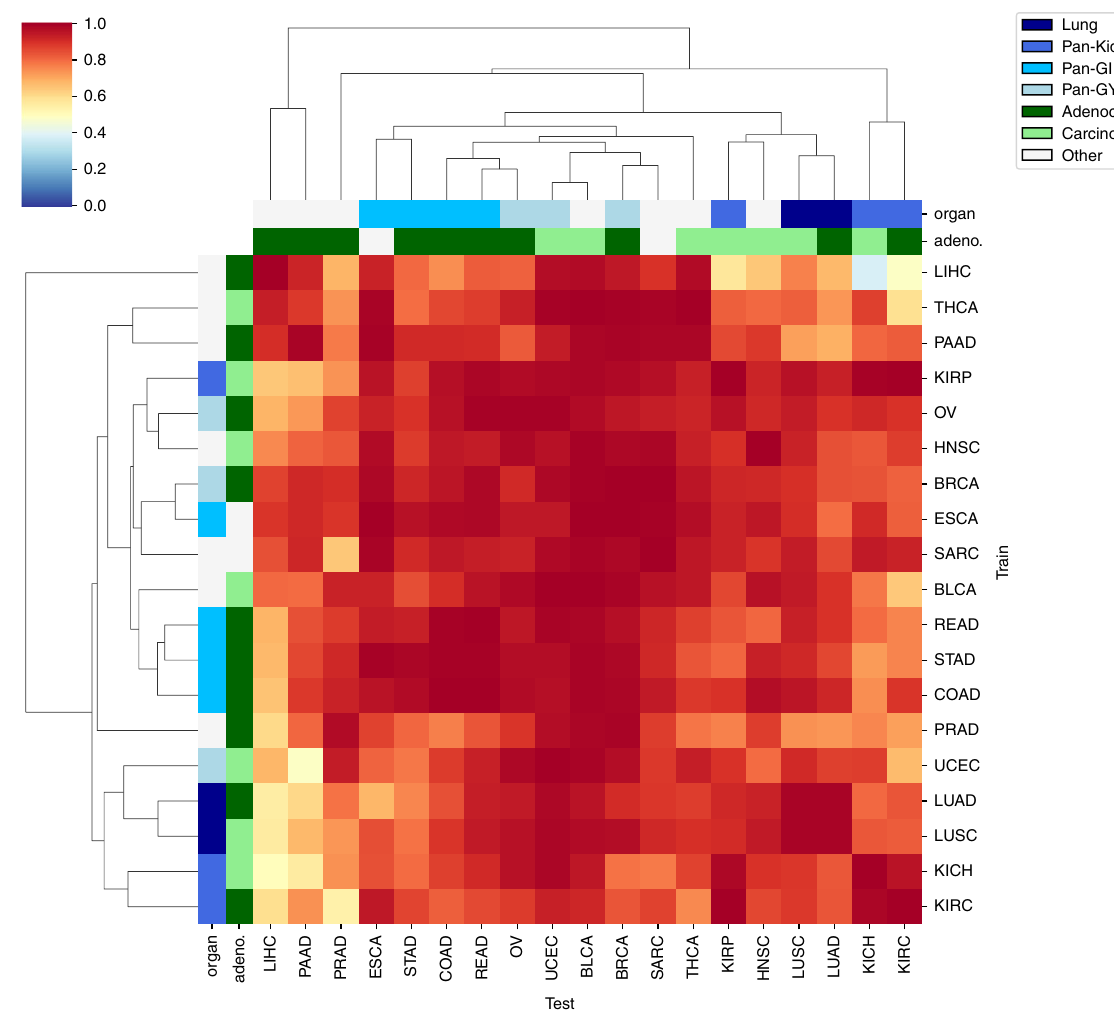
Fig. 4 Per-slide AUC values for cross-classi fi cation of tumor/normal status. The hierarchically clustered heatmap shows pairwise AUC values of CNNs trained on the tumor/normal status of one cancer type (train axis) tested on the tumor/normal status of another cancer type (test axis). Adeno-ness (adenocarcinoma vs. non-adenocarcinoma) and organ of origin (lung, kidney, gastrointestinal, gynecological) for each set are marked with colors on the margins. Cancers with ambiguous or mixed phenotype are marked as “ Other ”